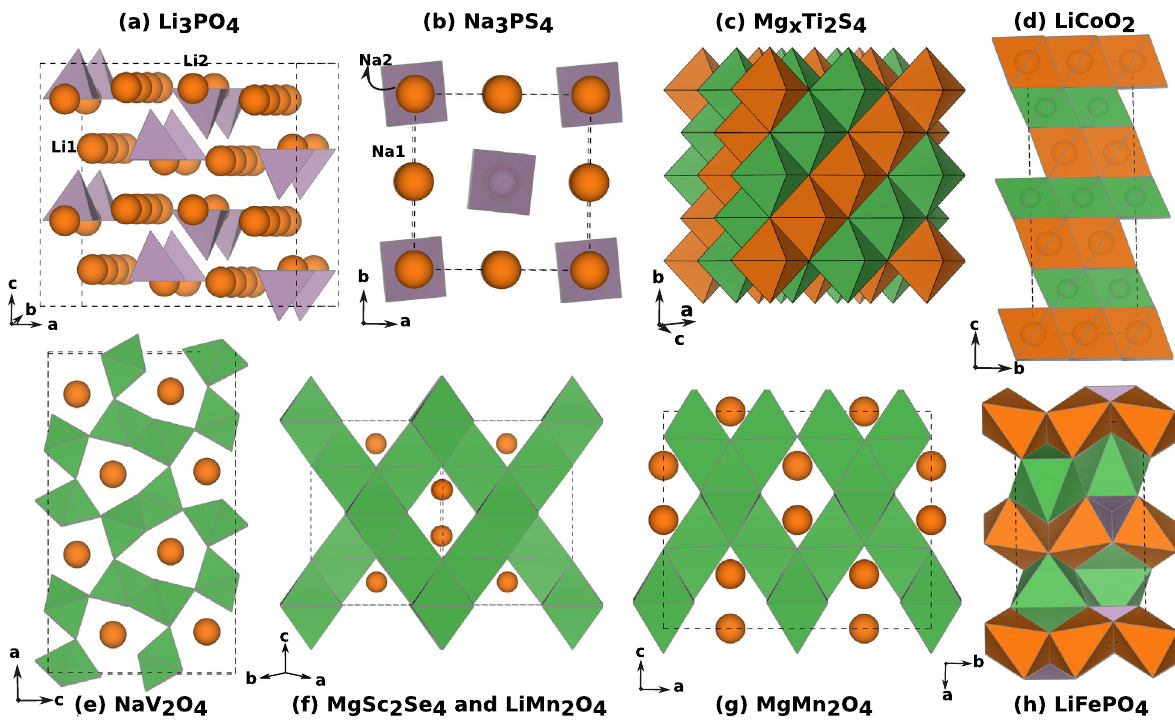
Fig. 1 Supercells of all the structures considered in this work. The migrating and the transition-metal ions are represented by orange and green spheres/polyhedra respectively. Phosphate ions are shown by purple polyhedra.